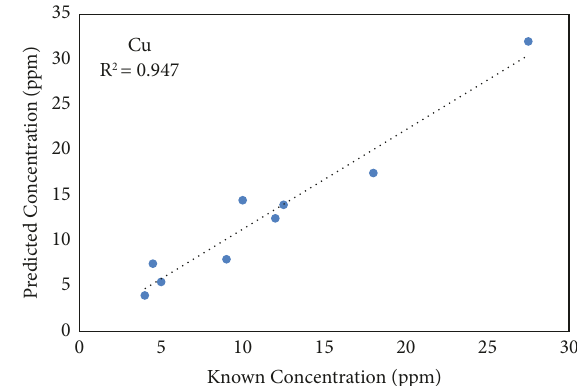
Figure 7: Artificial neural network regression curve of predicted versus known concentration of copper.